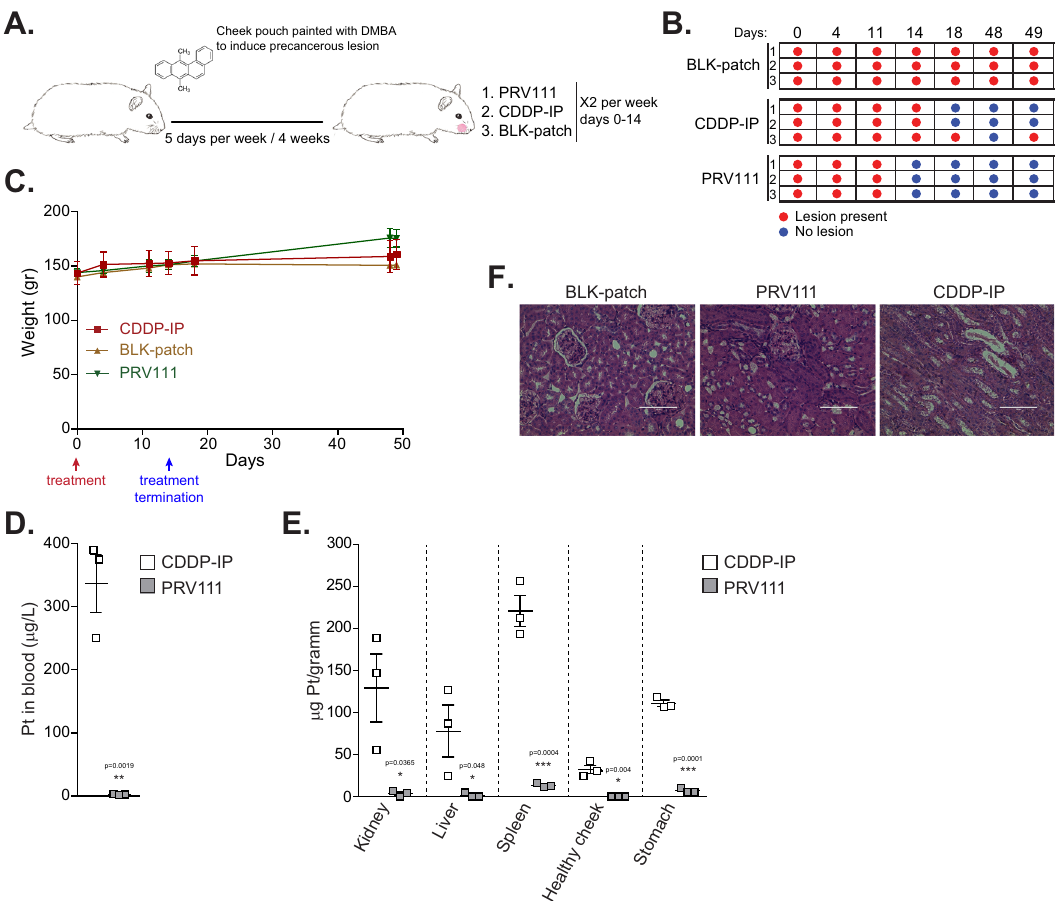
Fig. 4 PRV111 induced rapid and sustainable regression of carcinogen-induced oral premalignant lesions. A Schematic representation of the experiment. B Golden Syrian hamsters bearing DMBA-induced oral dysplastic lesion were treated with either BLK-patch, CDDP-IP or PRV111 (3 animals per group). Red circle indicates presence of the premalignant lesion, whereas blue circle indicates that the premalignant lesions was undetected. C Graph shows the average body weights for the 3 hamsters in each indicated group ± SEM. D Blood was collected from 3 animals per group after administration of the fi rst dose of CDDP-IP or PRV111, and level of cisplatin was quanti fi ed by ICP-MS, shown as average ± SEM ( p < 0.0019; Student ’ s unpaired t -test). E Hamsters treated with CDDP-IP or PRV111 ( n = 3) were sacri fi ced and indicated organs were harvested, weighted, processed, and biodistribution of cisplatin was assessed by ICP-MS, shown as average ± SEM ( p < 0.05 for all body organs analyzed; Student ’ s unpaired t -test). F Representative H&E stained